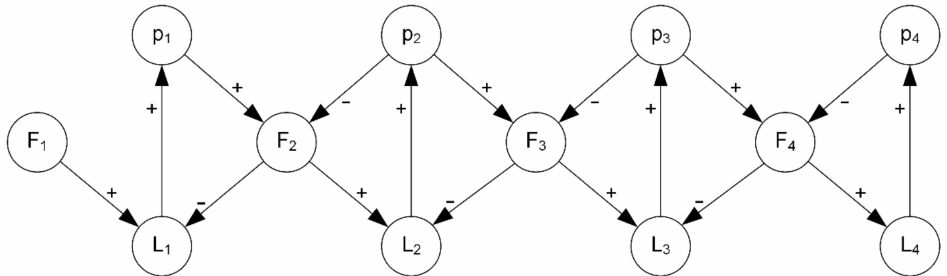
Figure 3. GP cause-and-effect graph of a process ( p i denotes pressure on the bottom of the i -th tank) including the mutual influence of process variables.